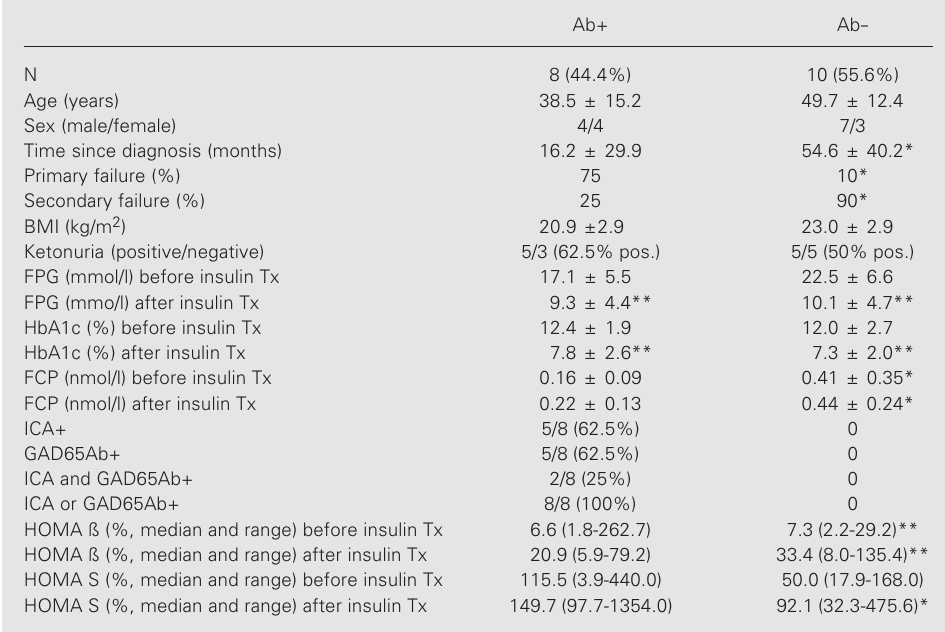
Table 1. Clinical and laboratory characteristics of diabetic patients with oral hypoglycemic agent failure according to positivity for ICA and/or